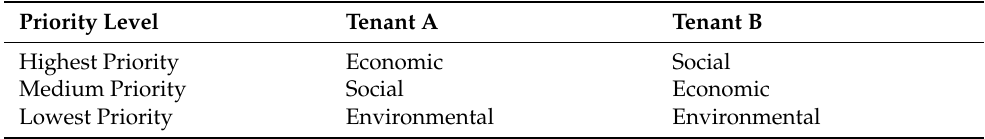
Table 3. Prioritization of economic, environmental and social incentives by each